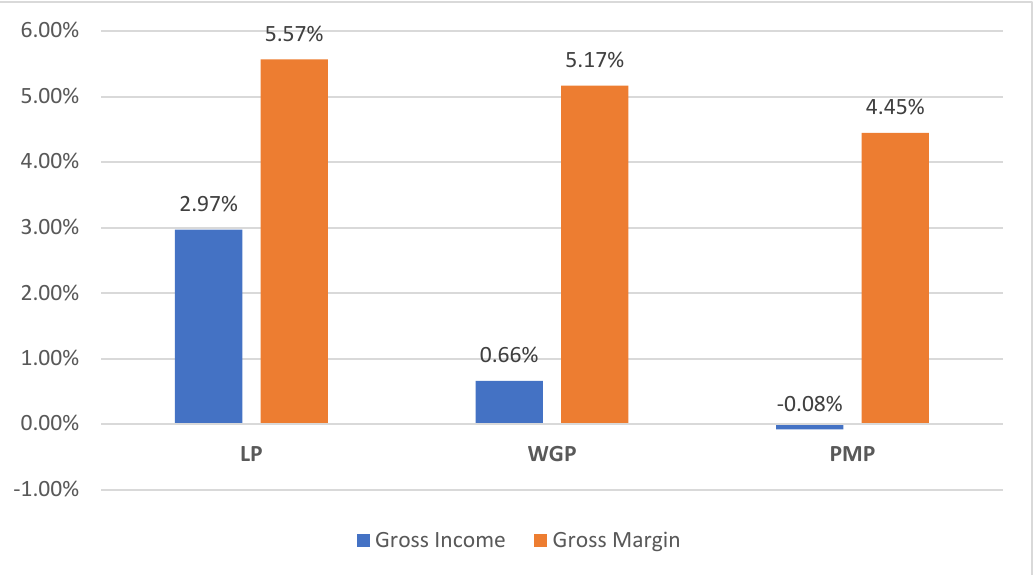
Figure 3. Changes in the economic indicators. Source: Our elaboration. The percentage changes for the three social indicators (labor use, annual work units, and seasonality) are shown in Figure 4 below. There is an increase in labor use by 1.23%, in LP, while in WGP and in PMP it decreases by 2.69% and 3.77%, respectively. Annual work units showed an increase of 1.23% in LP, while in WGP and PMP it shows a decrease of 2.69% and 3.77%, respectively. Finally, seasonality increased in LP by 1.23% while it decreased by 2.69% in WGP and by 3.77% in the PMP model.